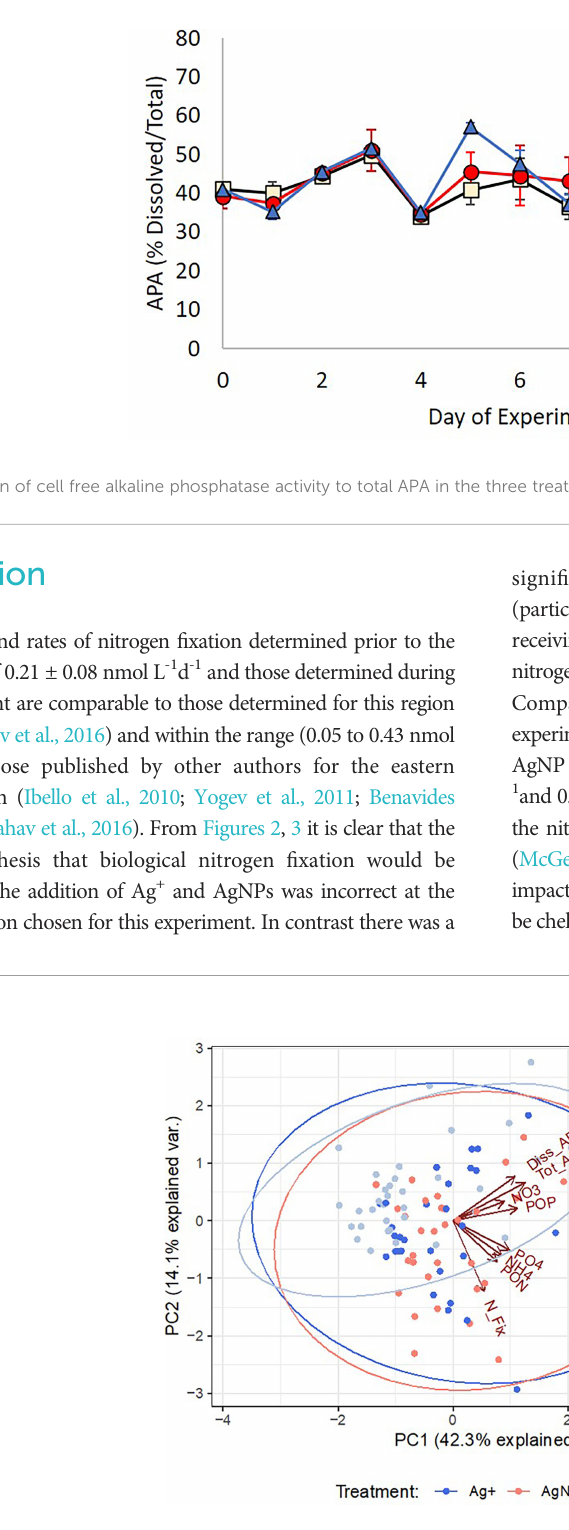
FIGURE 8 Principal component analysis showing the level of association between the variables analysed. PCA scores (colour-coded dots for each treatment) represent the number of observations used for PCA analysis ( n